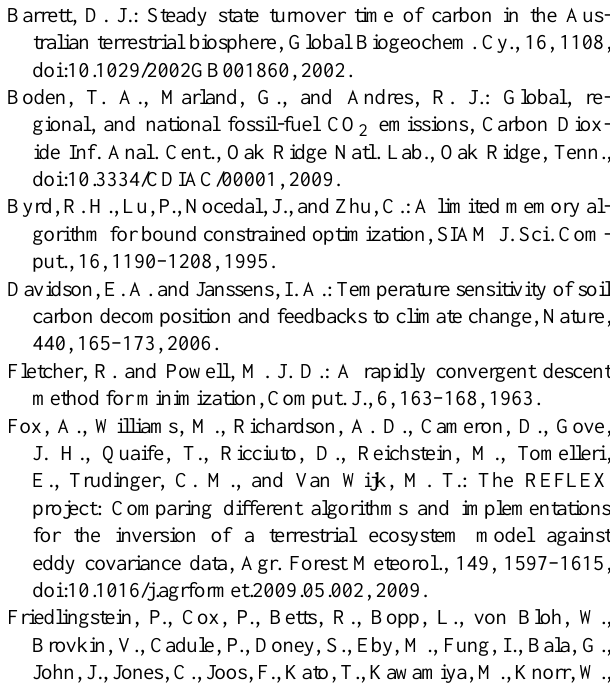
a purely mathematical point of view, a smaller minimum can be found outside the physically meaningful parameter